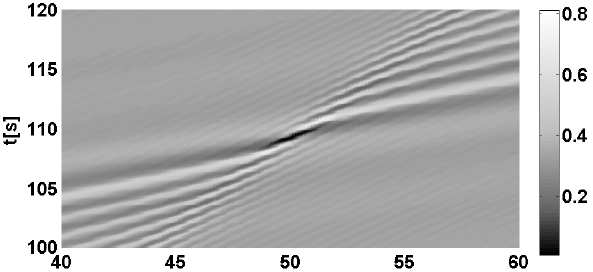
Fig. 10. The zoomed density plot of the variance of the total wave phase PV (x,t) . The minimal value PV foc is shown in black.